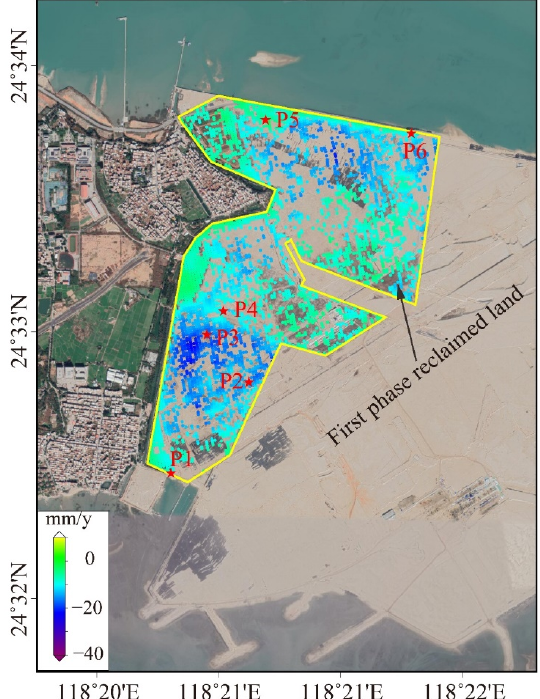
Figure A1. Locations of points P1–P6.